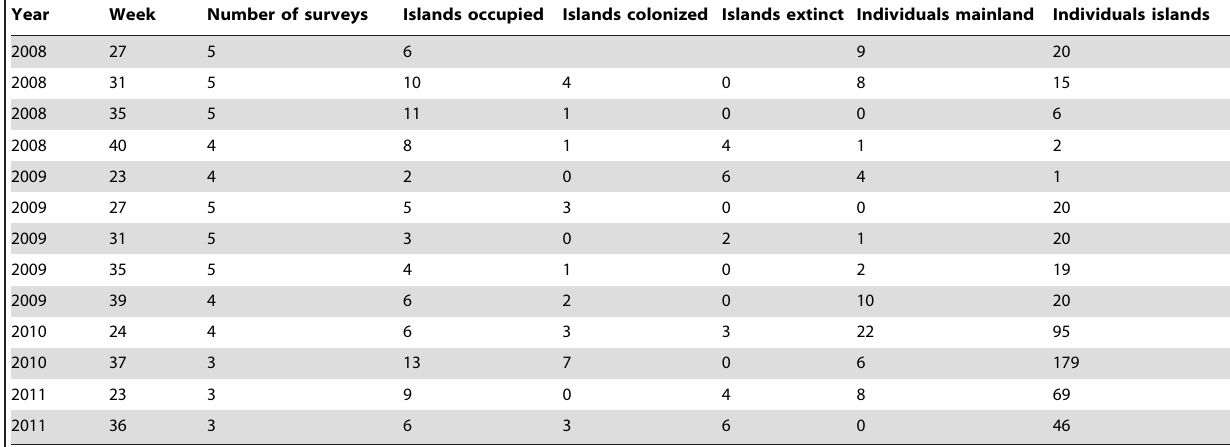
Table 1. Time schedule of the study and trapping